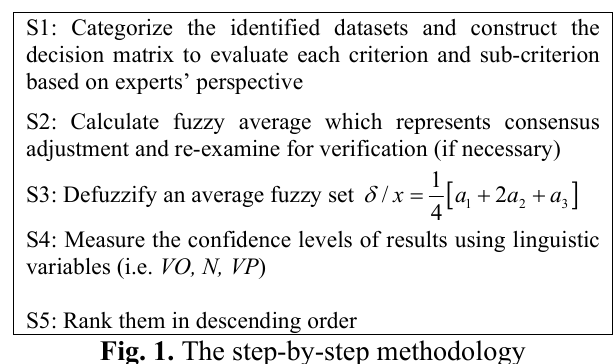
Fig. 1. The step-by-step